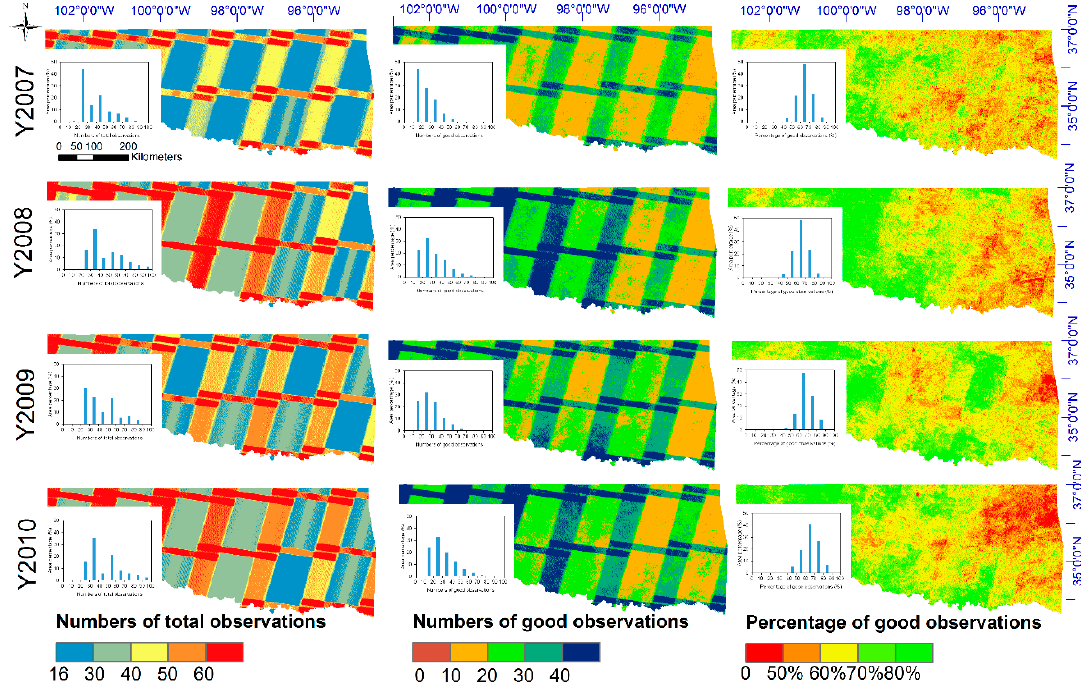
Figure 2. The data availability of annual Landsat TM/ETM+ images in Oklahoma from 2007 to 2010.